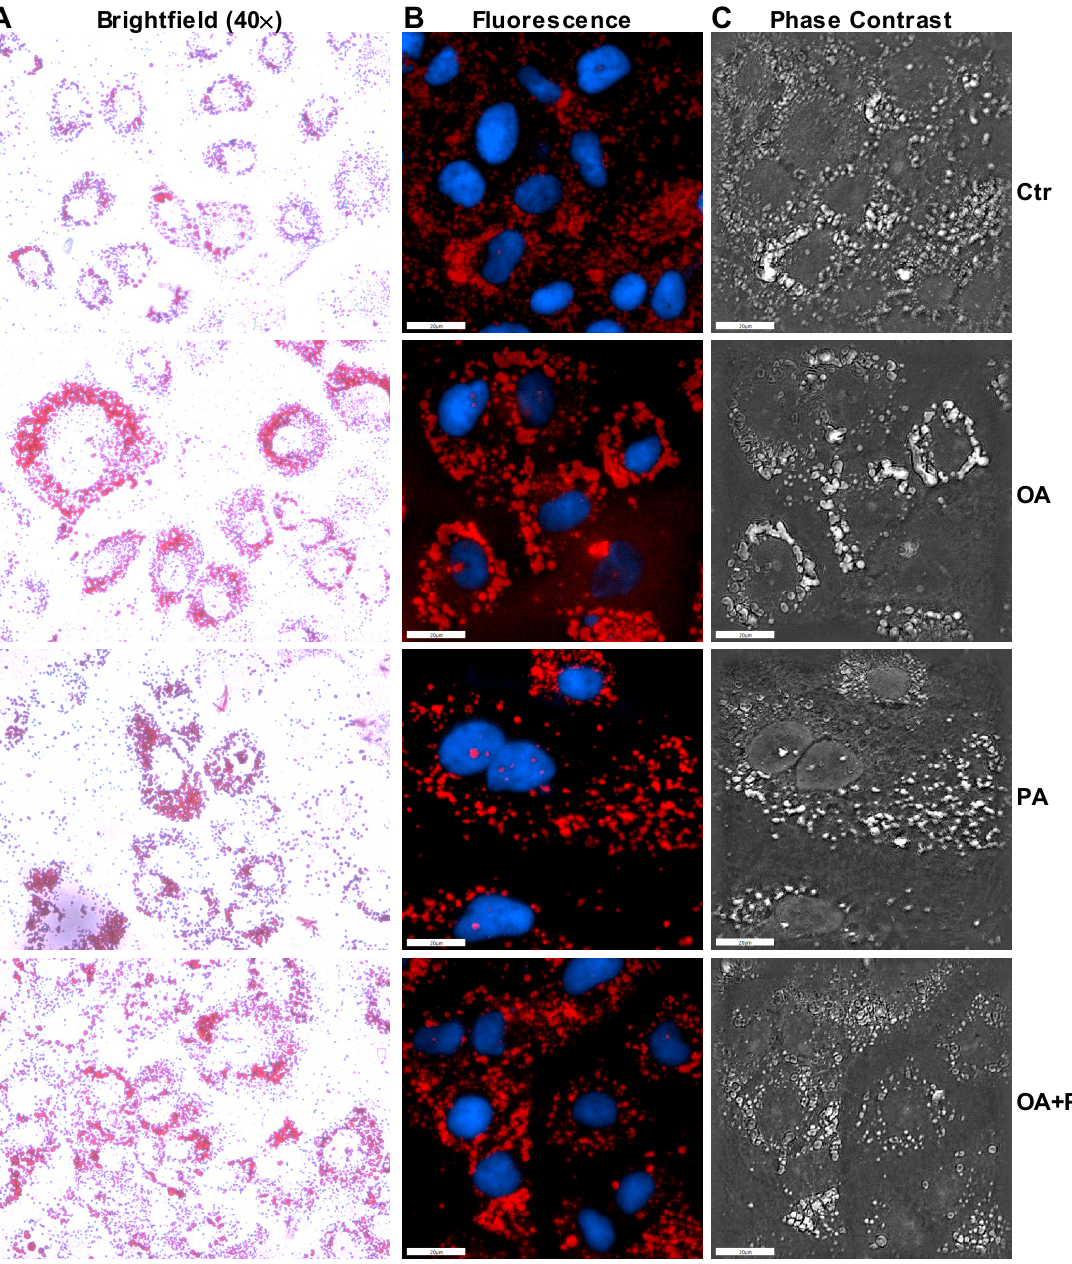
Figure 5. Oleate prevents palmitate induced morphological changes in Huh-7 cells. Huh-7 cells were treated without (Ctr) or with 0.2 mM of oleate (OA), palmitate (OP) or a combination of both (OA+PA) for 16 h prior to staining them with Oil Red O. Cells were used to determine the morphological changes and accumulation of lipids using the brightfield (Panel A ), fluorescence (Panel B ), and phase contrast (Panel C ) microscopy. Representative photographs of each condition is shown above in the figure.